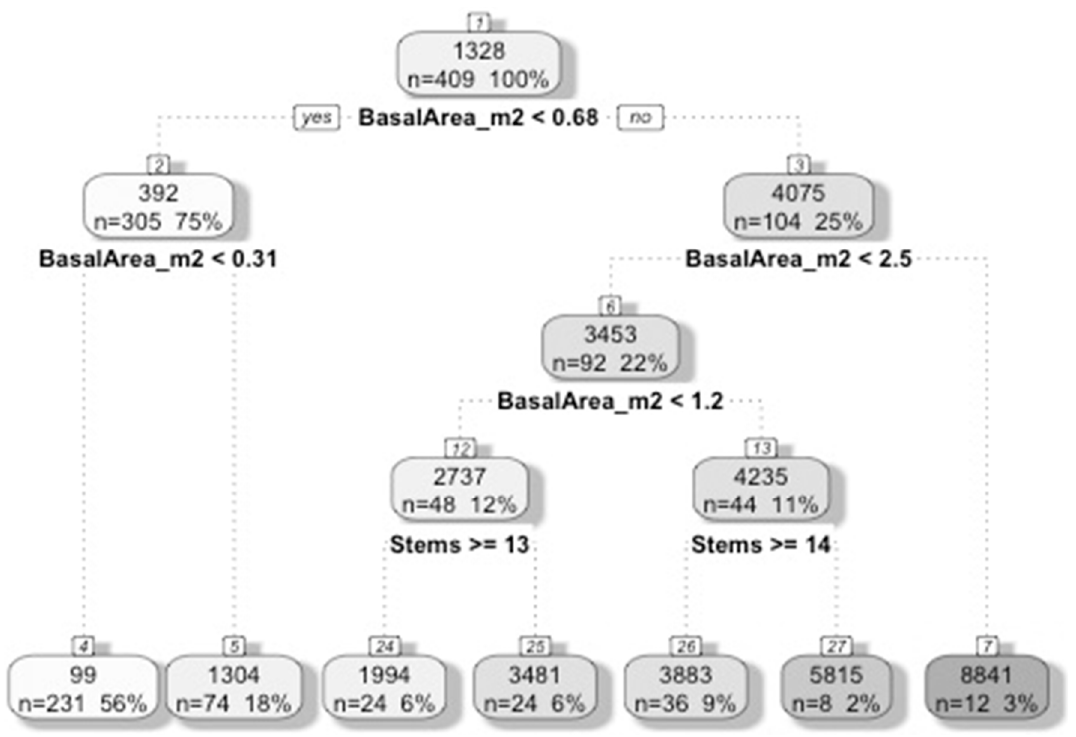
Figure 6. Unpruned RPART decision tree showing final bins and decision splits based on BA m 2 plot. The top number in each box shows the mean AGTC kg for the n plots in that box. The percentage reflects each box’s plots as a proportion of the total number of plots (409).